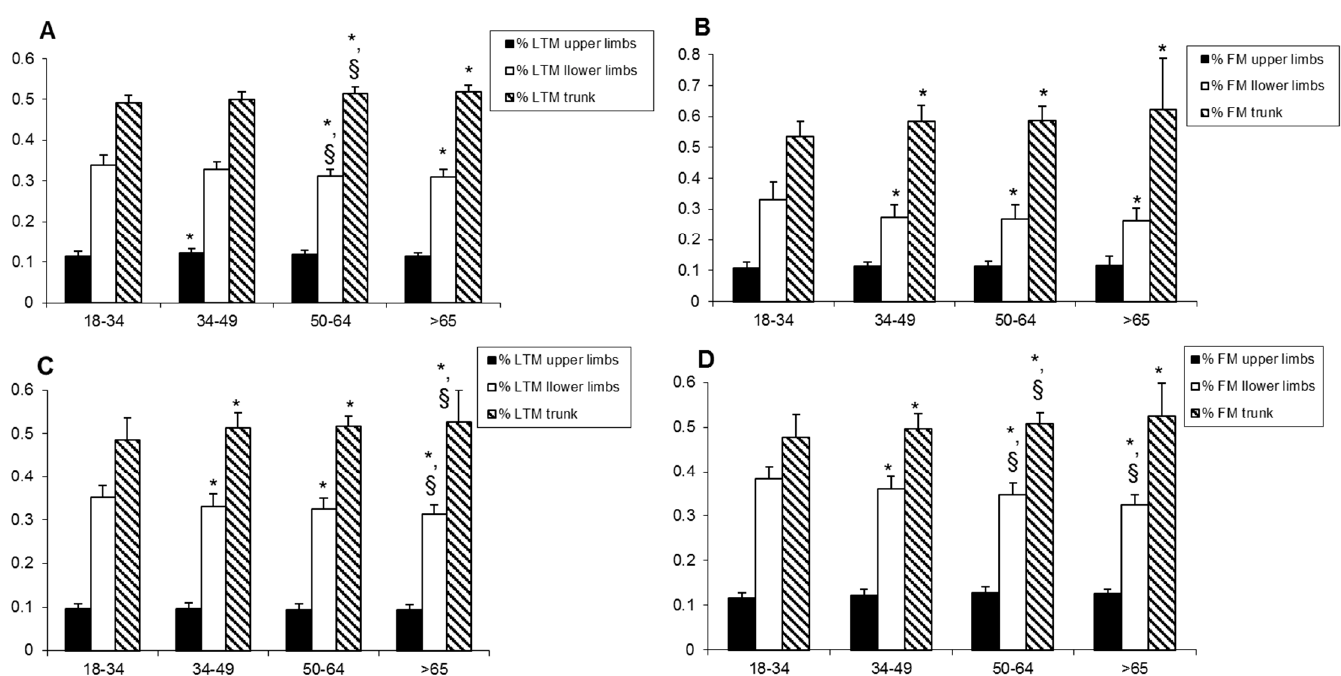
Figure 1. Repartition of lean tissue mass and fat mass in ( A , B ) male and ( C , D ) female obese participants according to age. Data are given by the mean ± SD. LTM: lean tissue mass; FM: fat mass. The Student’s t -test and Bonferroni Dunn procedure to control for the multiple comparisons problem were used to compare age groups. * indicates a significant difference with the 18–34 group, § indicates a significant difference with the adjacent younger age group.